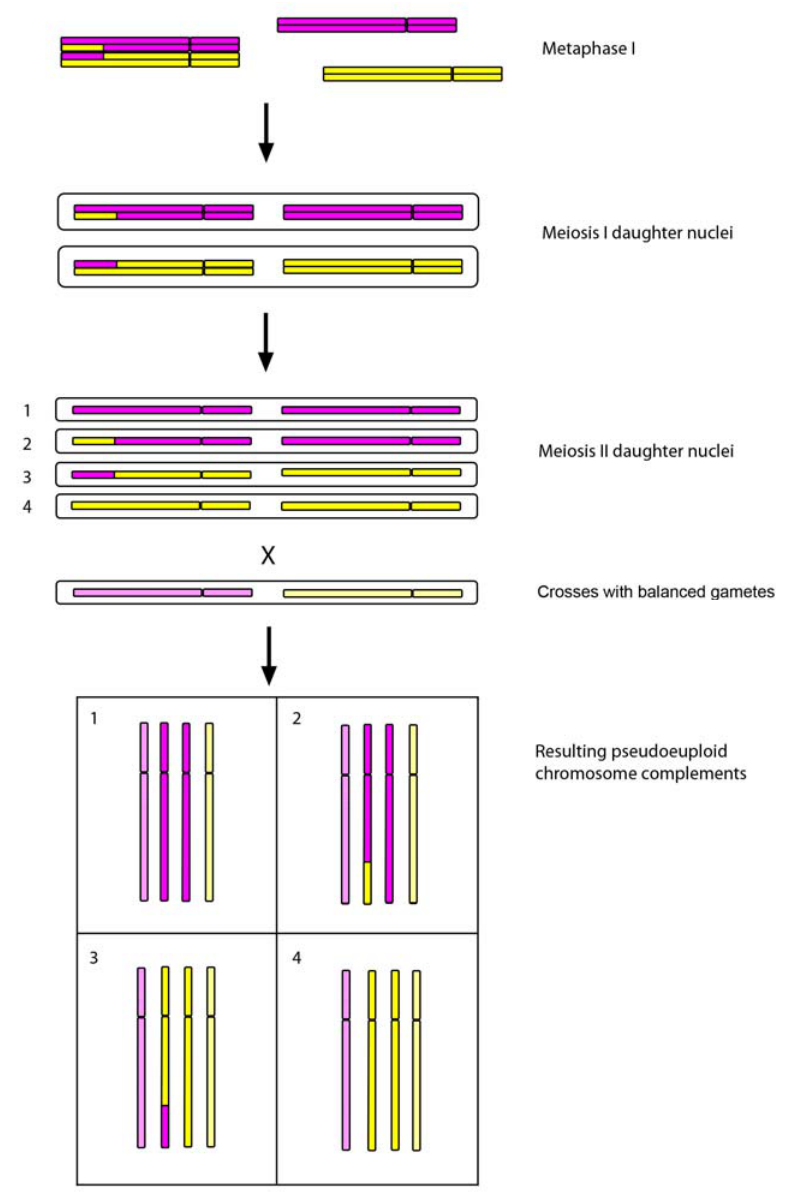
Figure 3. A model for pseudoeuploidy involving homeologous chromosomes. Homeologous chromosomes are labelled yellow or purple. An aberrant bivalent is formed between homeologous chromosomes, and a single crossover results in a homeologous translocation; the two remaining homeologues remain unpaired (univalents). Note that if the translocation had already occurred, this might lead to aberrant pairing. Due to missegregation, daughter cells of the 1st meiotic division receive two homologous chromosomes. The resulting gametes from the 2nd meiotic division have the correct numerical complement but are unbalanced. Plants arising from a cross between gametes 1-4 result in the corresponding complements (chromosomes shown in an unreplicated state). Note that other aberrant pairing configurations such as two homeologous bivalents or a quadrivalent may also result in homeologues segregating to the same daughter nuclei in the 1st meiotic division. Such aberrant meioses were observed in 1st-generation synthetic Brassica napus lines; monosomic/trisomic plants for chromosome 1 were generated at a frequency of ~5% following backcrossing to natural B. napus [41]. Tragopogon allotetraploids in the wild were found to exhibit reciprocal aneuploidy for homologous or homeologous chromosomes